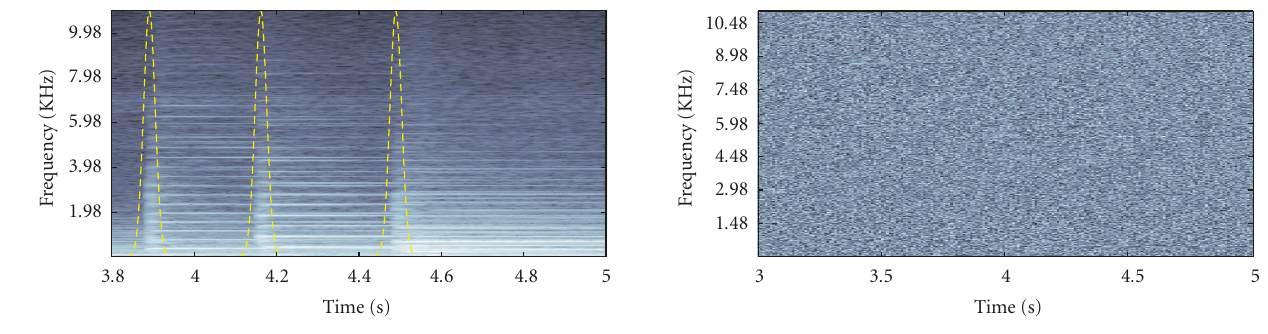
Figure 6: The phase plane of the STFT calculated in Figure 4. Un- manipulated, such a phase plane looks very much like a matrix of noise.